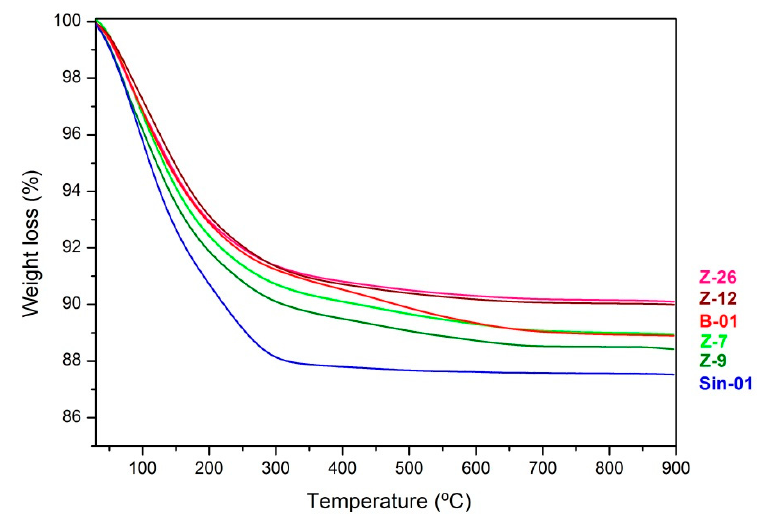
Figure 5. TGA curves of natural mordenites, synthetic one (Sin-01) and bentonite